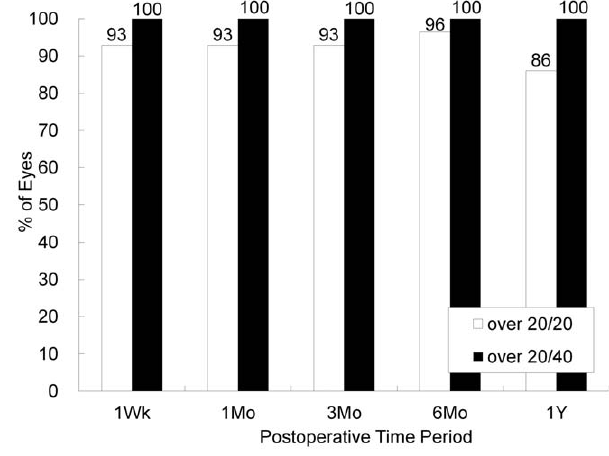
Figure 1. Changes in best spectacle-corrected visual acuity (BSCVA) after toric implantable collamer lens implantation. BSCVA= best spectacle-corrected visual acuity doi:10.1371/journal.pone.0056453.g001 PLOS ONE |